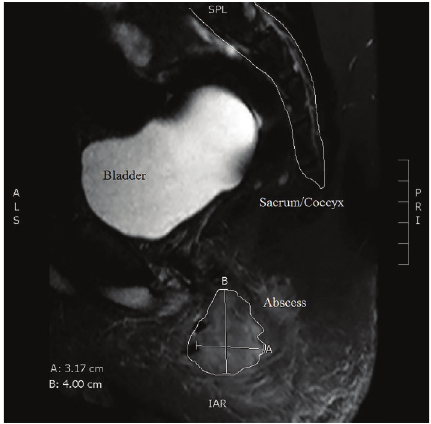
Figure1:T2MRI,sagittalviewsacrum/coccyx.Magneticresonance imaging revealing an approximately 3.0 × 4.0cm phlegmon consis- tent with perirectal